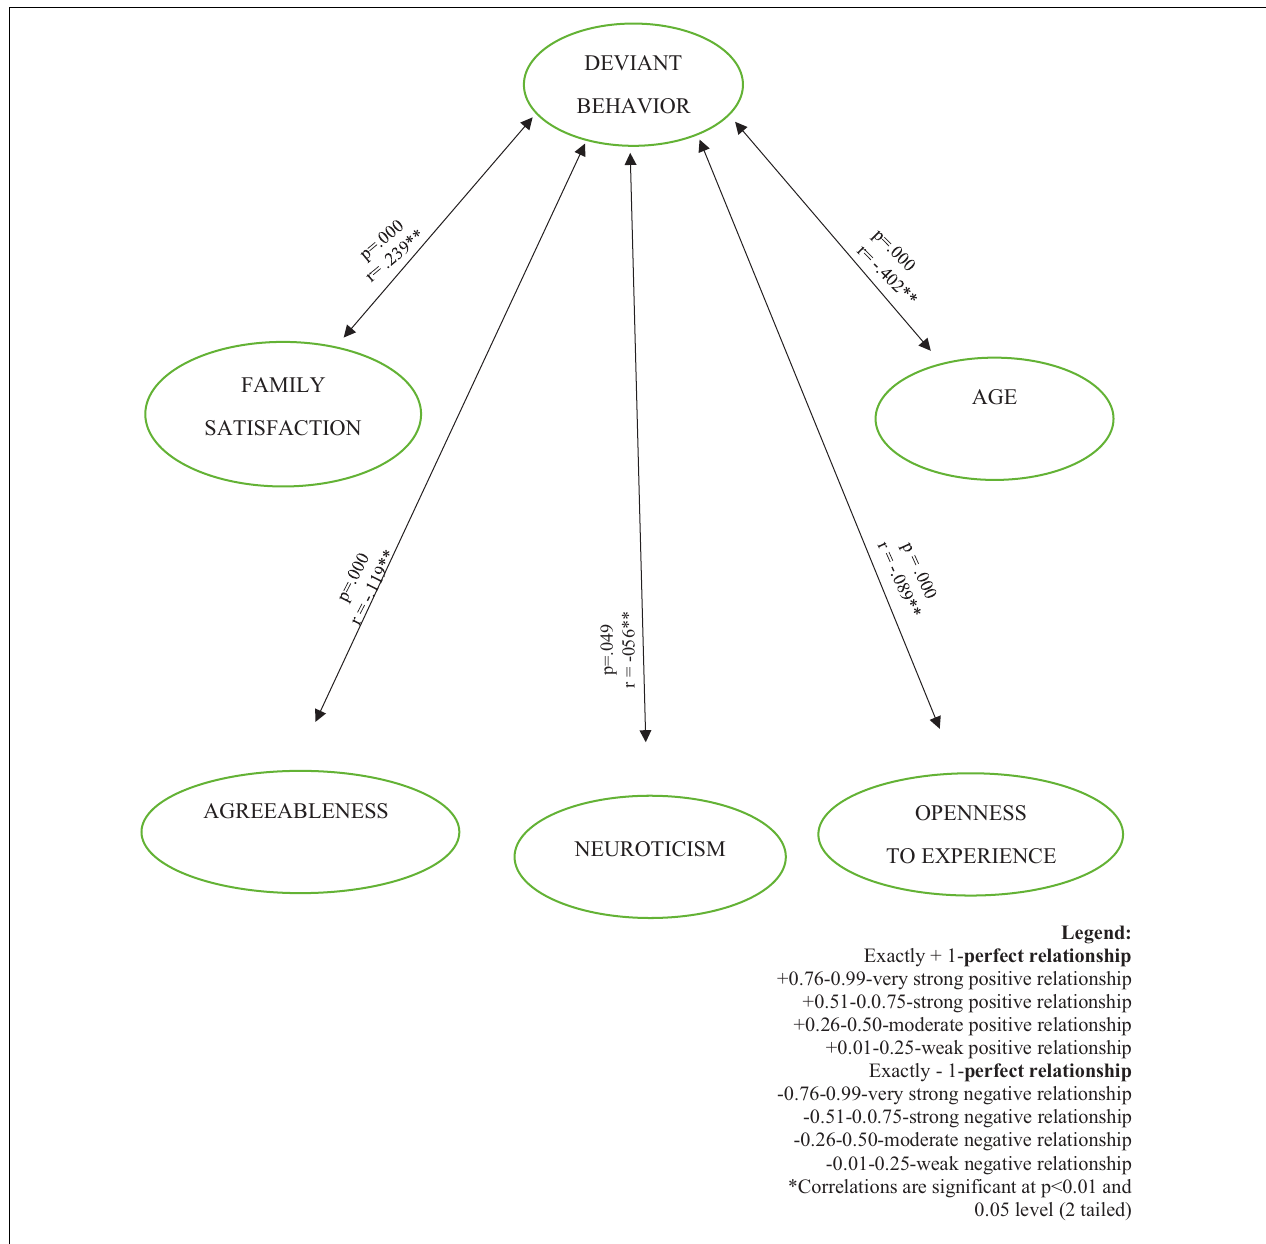
FIGURE 2 | Path analysis of deviant behavior, age, family satisfaction, and personality traits. Exactly + 1- perfect relationship. +0.76-0.99-very strong positive relationship. +0.51-0.0.75-strong positive relationship. +0.26-0.50-moderate positive relationship. +0.01–0.25-weak positive relationship. Exactly - 1- perfect relationship. – 0.76–0.99-very strong negative relationship. – 0.51–0.0.75-strong negative relationship. – 0.26–0.50-moderate negative relationship. – 0.01–0.25-weak negative relationship. *Correlations are significant at p < 0.01 and 0.05 level (2